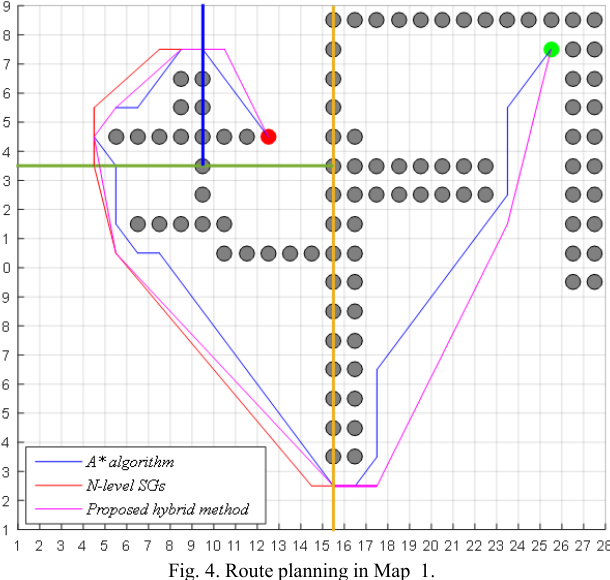
Fig. 4. Route planning in Map_1.